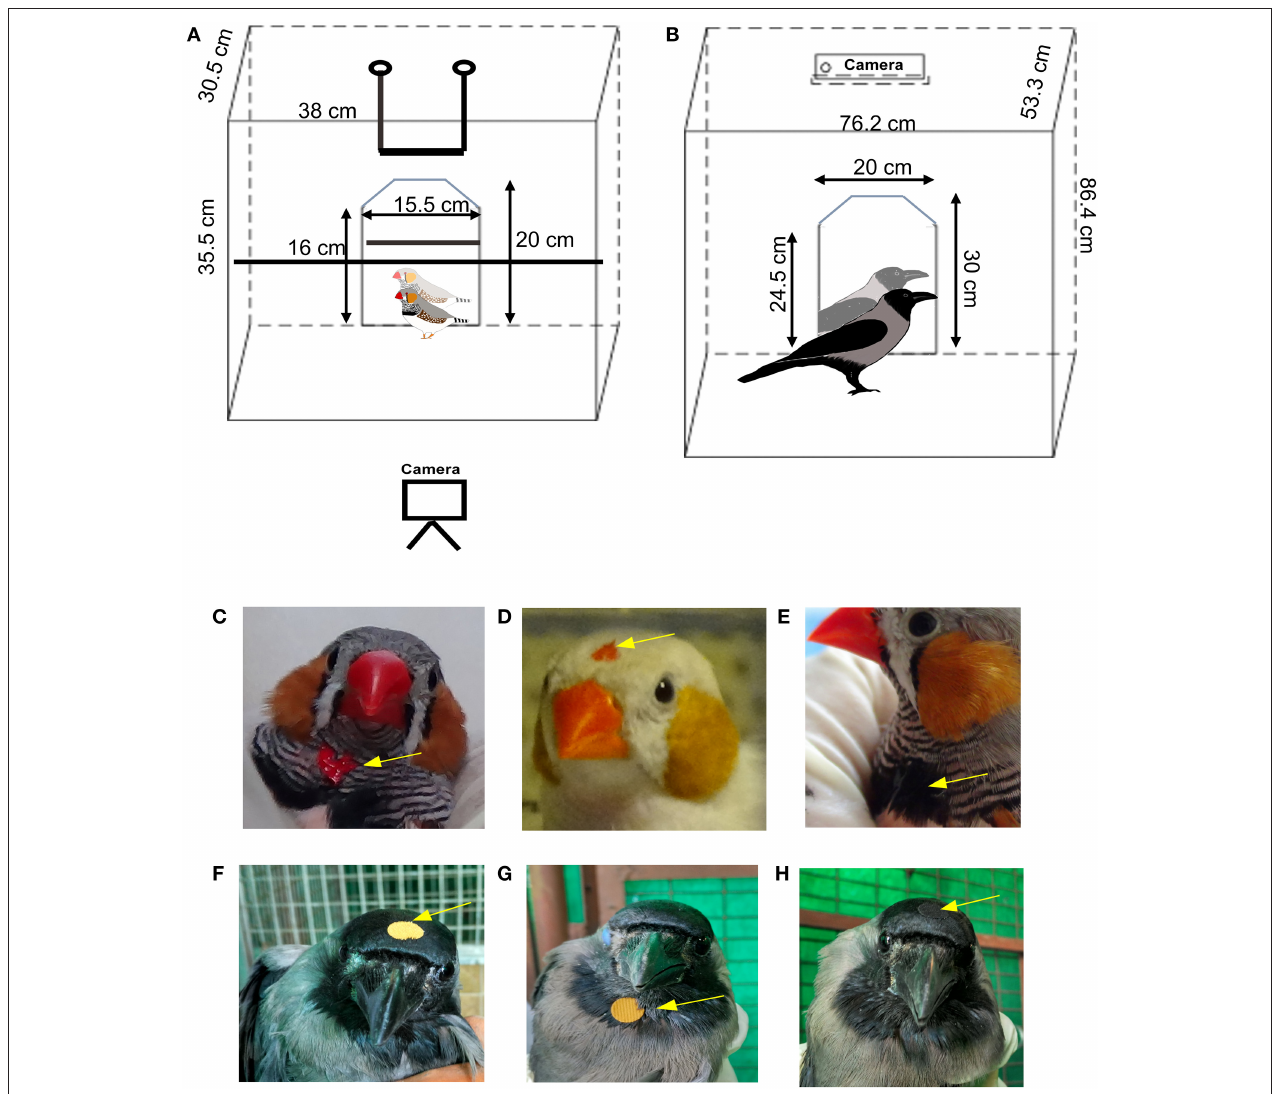
FIGURE 1 | Schematic diagram of the behavioral setup used for testing mirror self-recognition in passerines and placement of the mark. (A) For zebra finches, two perches were placed in the cage and the camera was placed in front of the cage facing the mirror whereas for (B) house crows, the perch was removed during the MSR tests and the camera was placed above the cage. Placement of the “mark” on (C–E) zebra finches and (F–H) house crows. Arrows indicate the position of a red dot on a male zebra finch’s (C) throat or (D) head. (E) A black dot was painted on the tuft of black feathers on the throat of zebra finch as a control to test whether they would attempt to remove the mark (BlThrMirr control, see text for details). A yellow sticker was placed on the (F) head or (G) throat area of a house crow for the MSR test. (H) The arrow indicates the position of a black sticker placed on the head as a control (BlHdMirr control condition) for house crows.